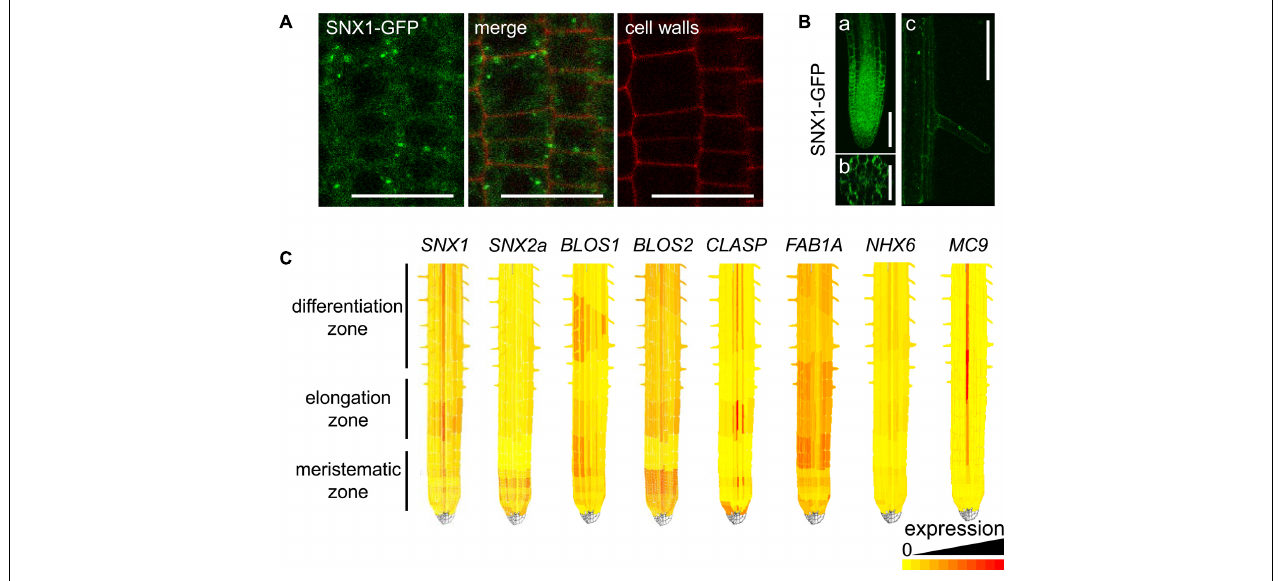
FIGURE 3 | Expression pattern of SNX1 and genes encoding SNX1 interactors along the root. (A) Subcellular localization of a complementing SNX1-GFP fusion in cells of the root meristematic zone. (B) Tissue-level expression of SNX1-GFP: (a) optical longitudinal section of the root meristematic and elongation zones; (b) optical cross-section of the region between the elongation and early differentiation zones; (c) a root hair cell. (C) Visualization of SNX1-interactor-encoding gene expression along the root using the ePlant tool. Relatively low expression is represented by a yellow color, high expression is shown in darker orange and